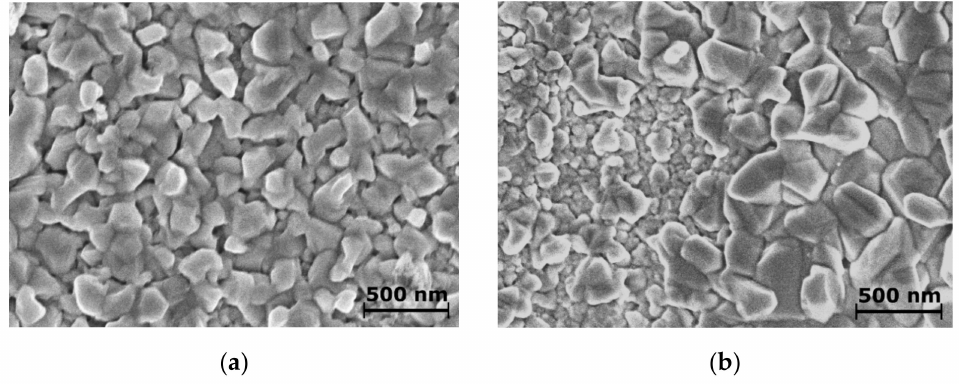
Figure 2. SEM images of 100 nm thick Bi coatings on Au obtained from Bi electrodeposition solution with the additive Triton X-100 ( a ) and without it ( b